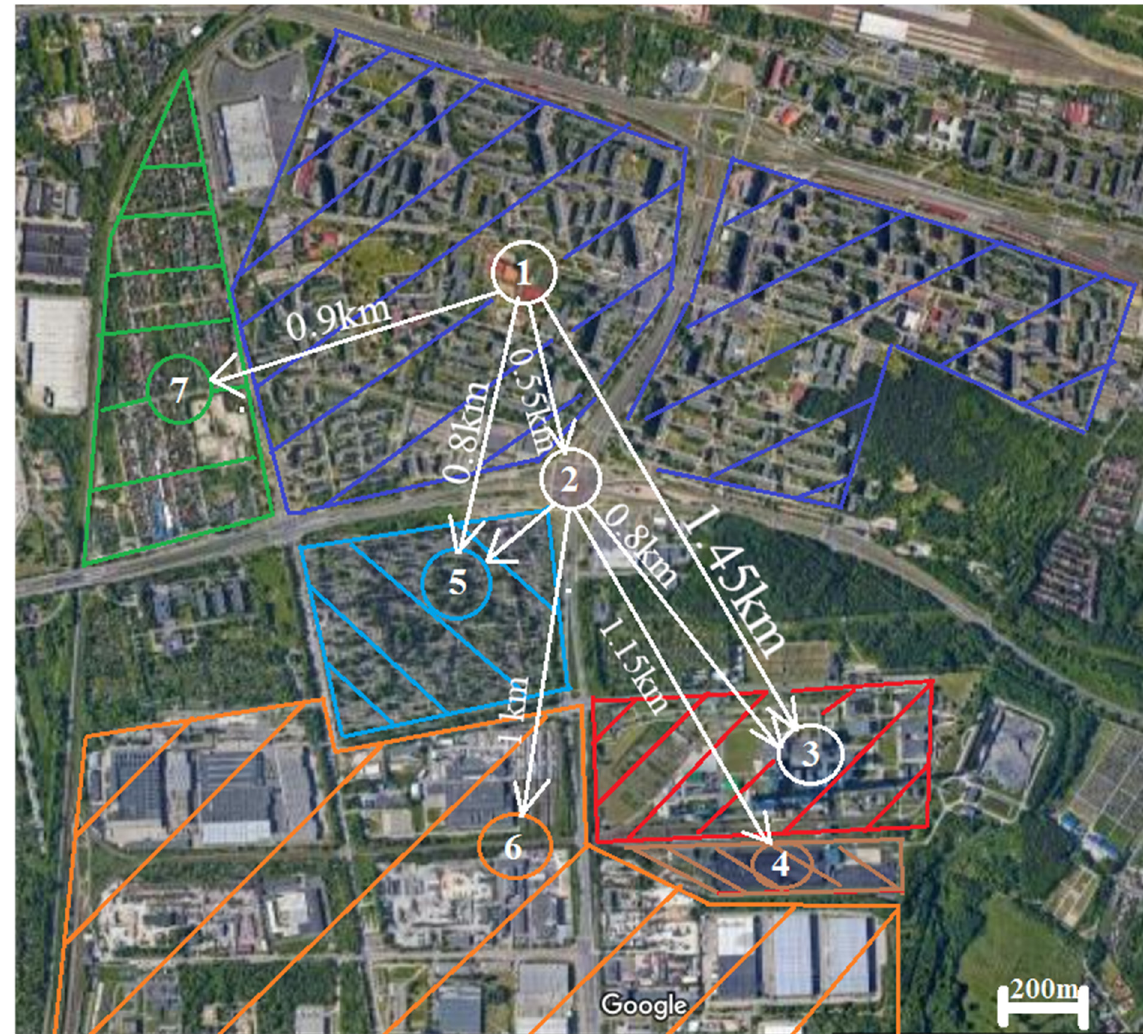
Figure 8. Map of the main areas affecting air quality: 1—the area of a multi-family housing estate with a VIEP station; 2— analyzed street intersection; 3—EC4 heat and power plant; 4—hard coal storage; 5—the cemetery area; 6—industrial areas; 7—the area of the estate of single-family houses (photo background source: Google Earth Pro).